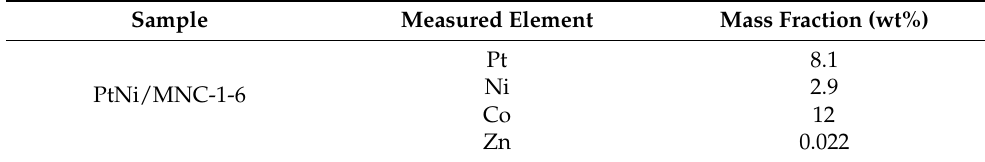
Figure 1. XRD patterns of PtNi/MNC-1-6 and Pt/MNC-1-6. Table 1. Content test of each element in the PtNi/MNC-1-6 sample.